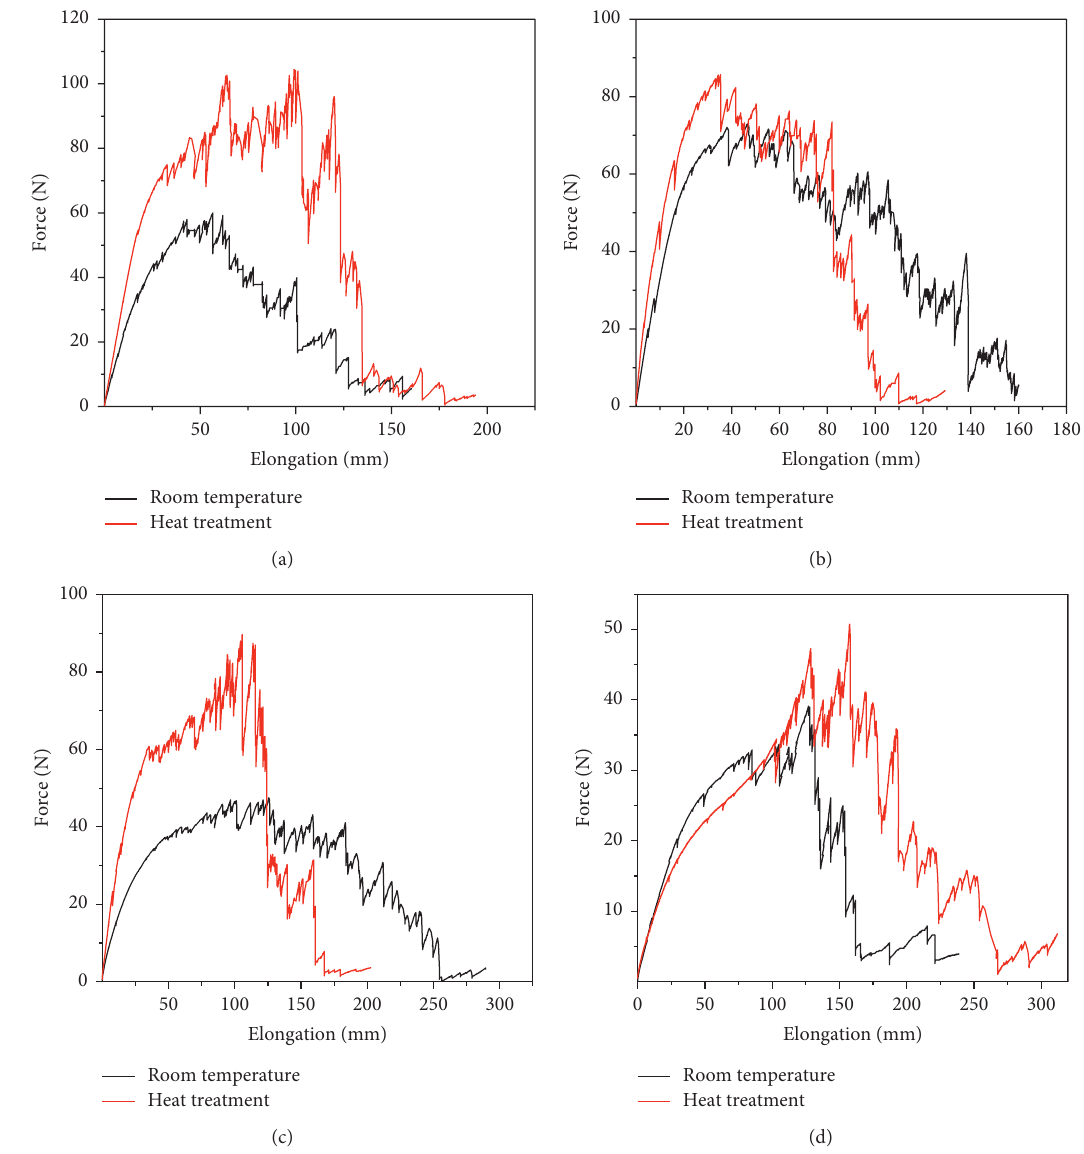
Figure 15: Effect of heat treatment on material properties. (a) Porosity � 51.5%. (b) Porosity � 57.6%. (c) Porosity � 63.7%. (d) Porosity �